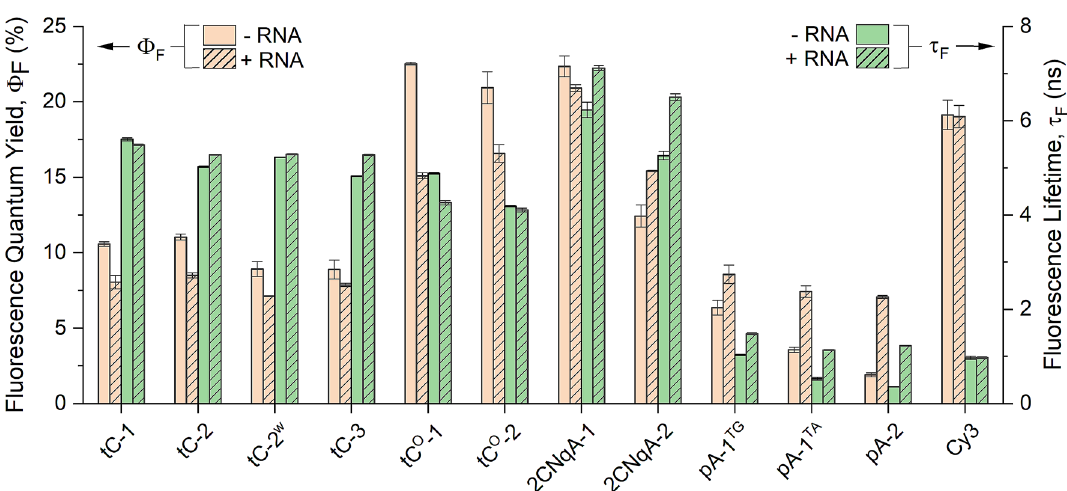
Figure 4. Fluorescence quantum yield (Φ F , red bars) and lifetime (τ F , green bars) of the single-stranded (plain bars) and RNA-bound (striped bars) gapmers. Presented values are mean ± standard deviation from two independent replicates. The corresponding numeric data are provided in Supplementary Table